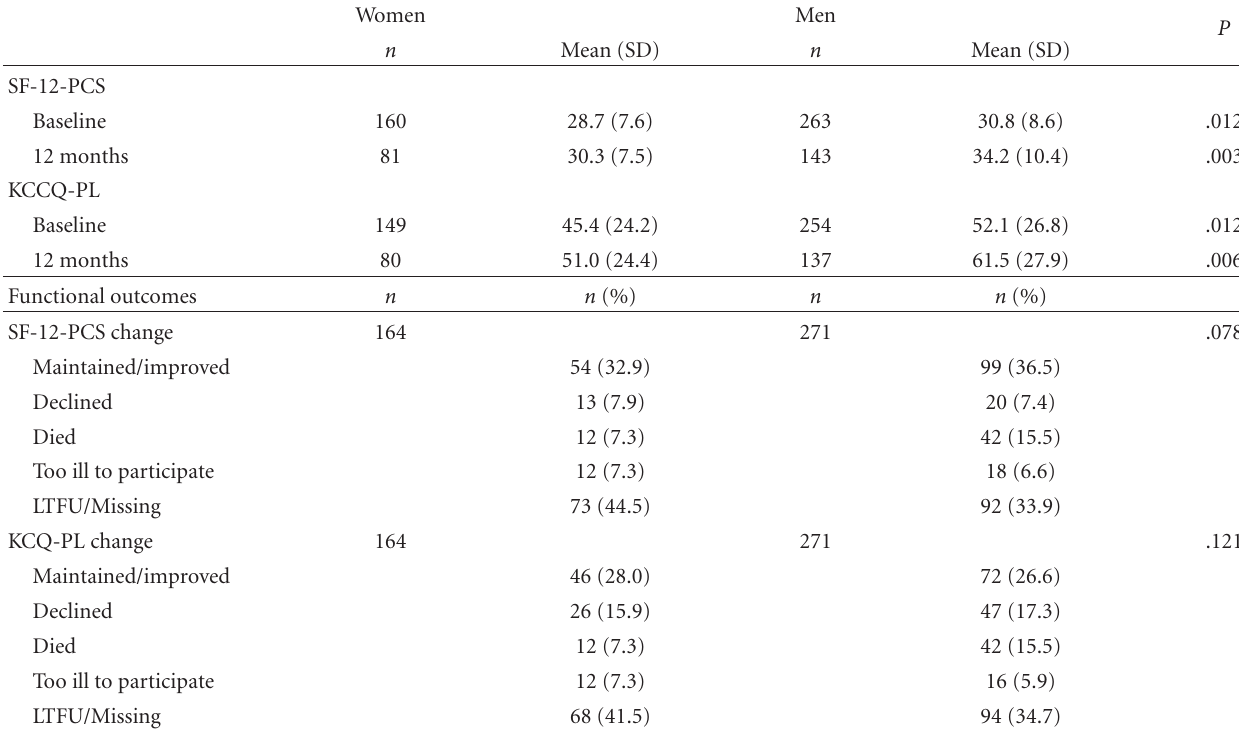
Table 4: Baseline and 12-month functional scores and functional outcomes by